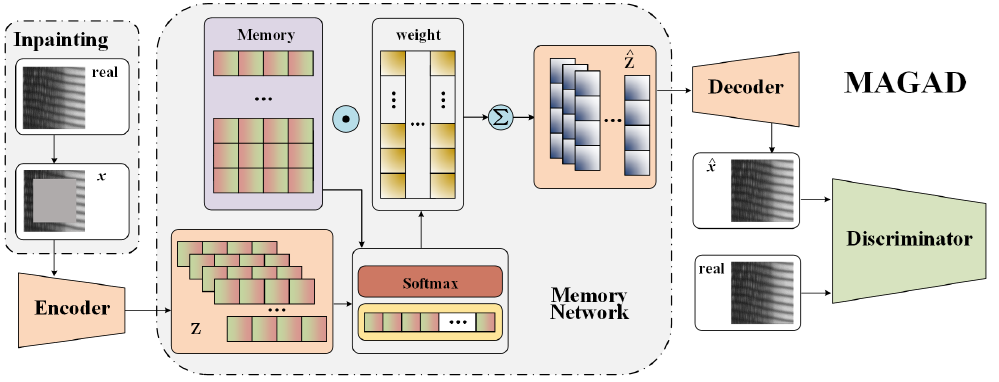
Figure 5. Structure of